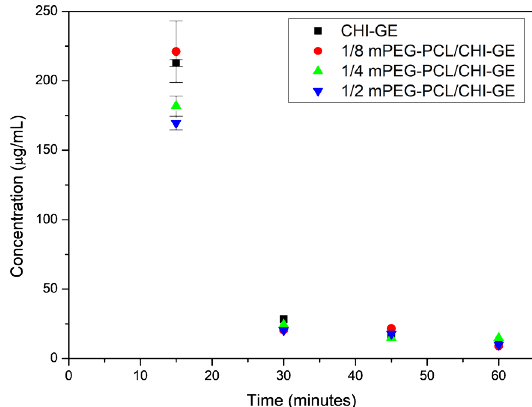
Figure 6. In vitro Gentamicin burst release from (black) CHI-GE, (red) 1/8 mPEG-PCL/CHI, (green) 1/4 mPEG-PCL/CHI and (blue) 1/2 mPEG-PCL/CHI at 15, 30, 45 and 60